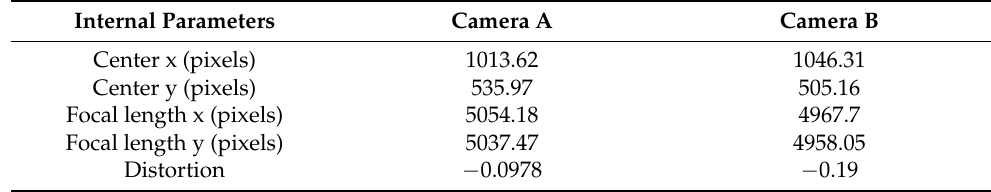
Figure 6. Schematic of binocular stereo visual effect of coaxial dual-camera system. Table 1. Internal parameter calibration data.